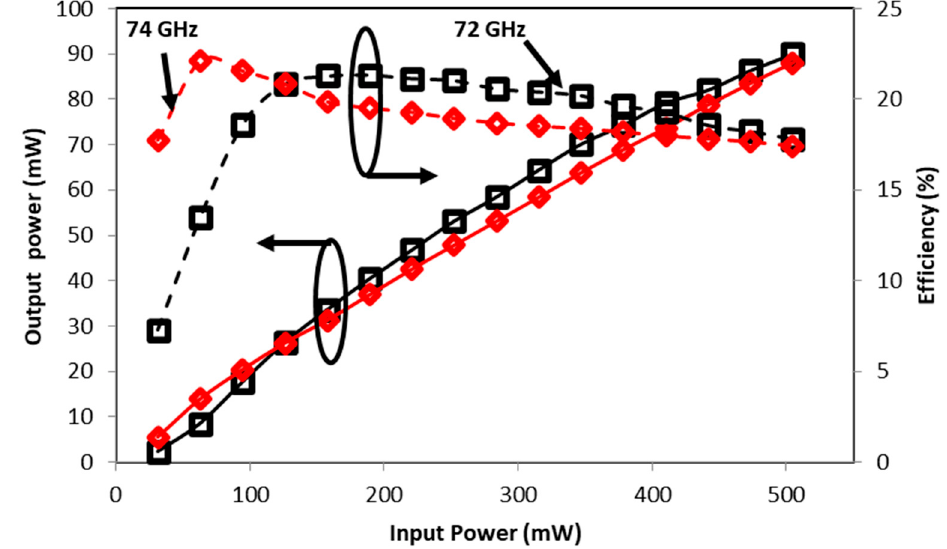
Figure 4. Measured output power and efficiency for the MMIC (squares) and hybrid (diamond) circuits at 72 GHz and 74 GHz, respectively.